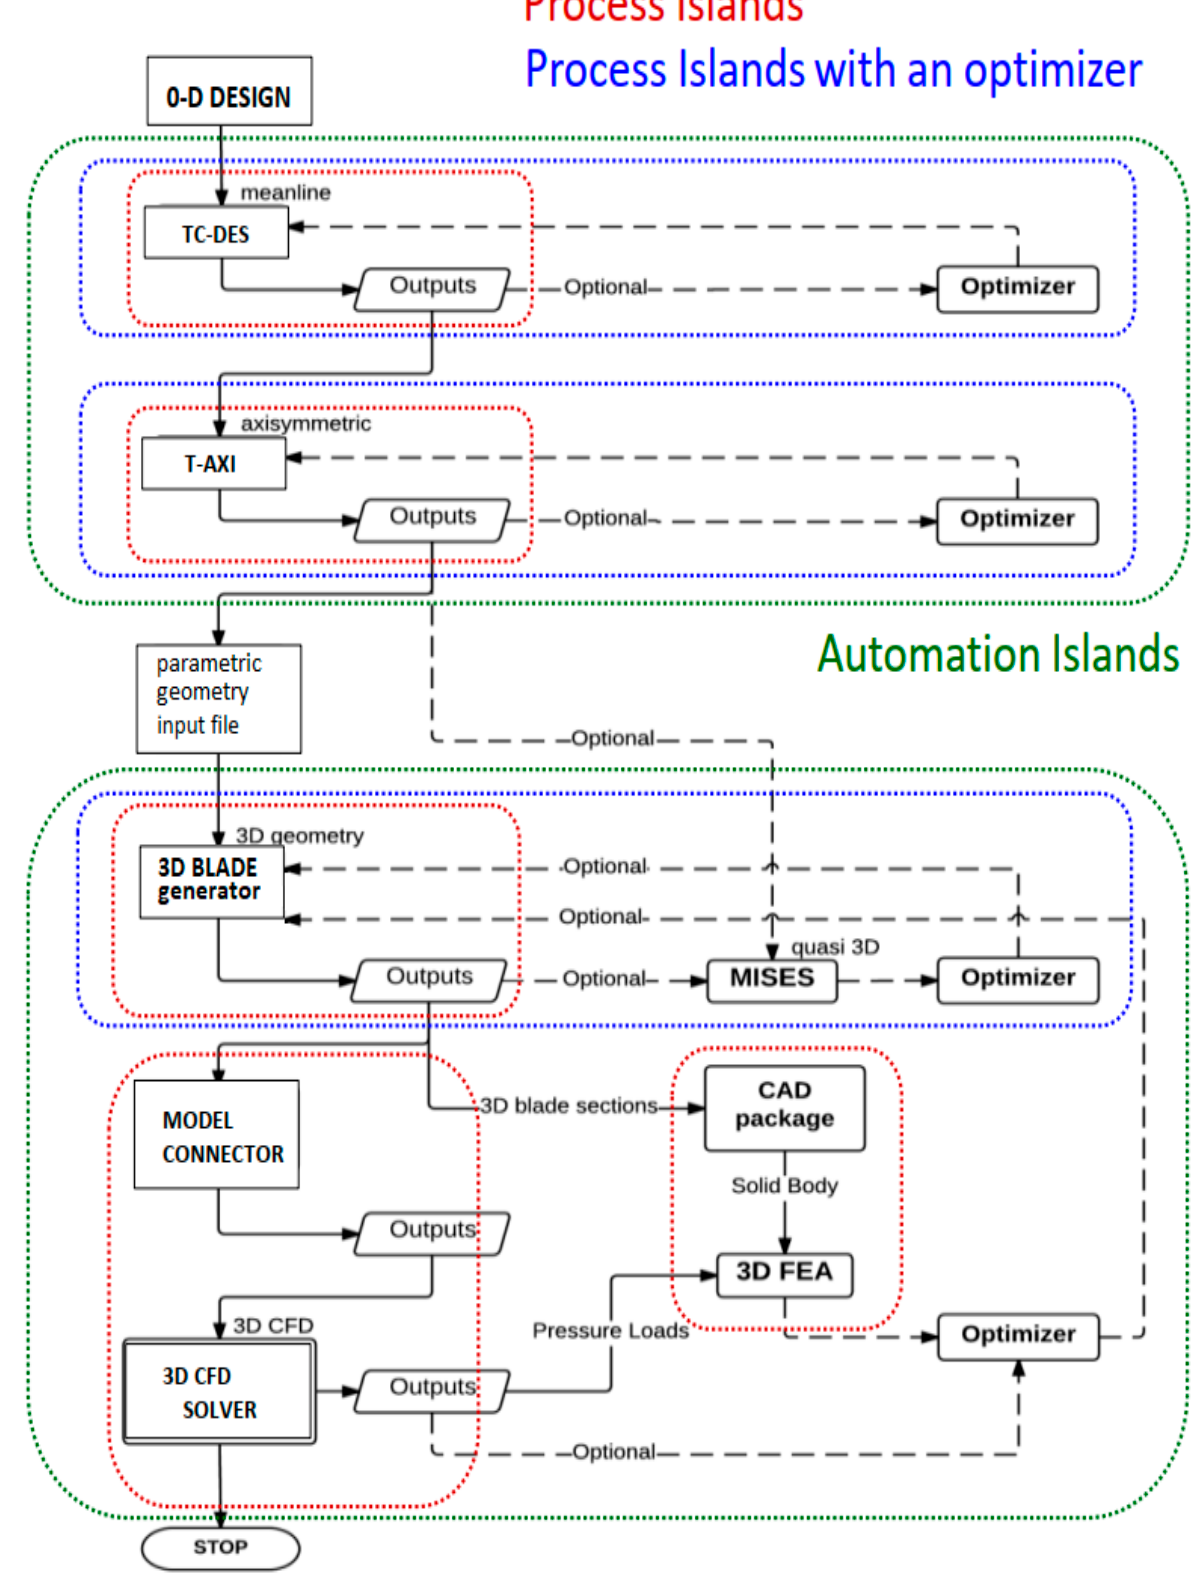
Figure A2. Automated framework integrated with an optimizer for multiphysics.